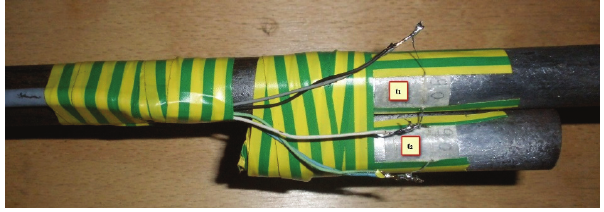
Fig. 6. Temperature compensation element